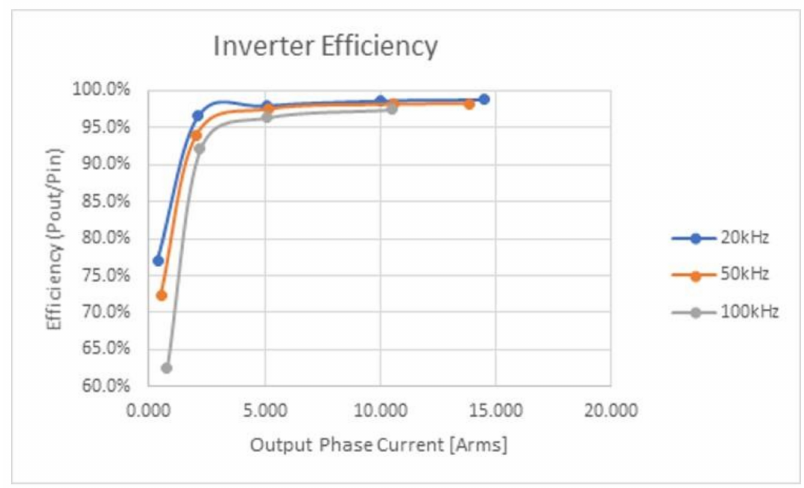
Figure 28. Inverter efficiency at motor current variation (rms) for three switching frequencies: 20 kHz, 50 kHz, 100